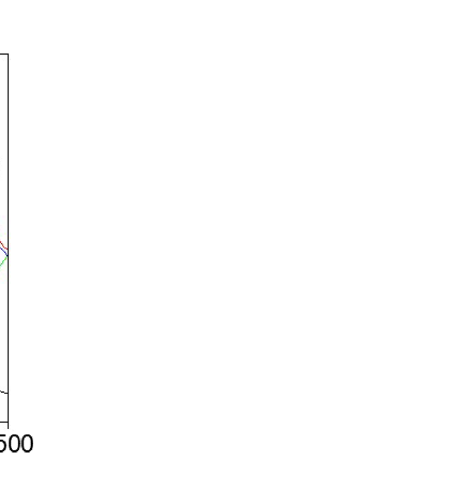
Figure 7. FTIR absorption spectra in the 1800–1500 cm −1 range of l-lysine after the hydrothermal treatment at 200